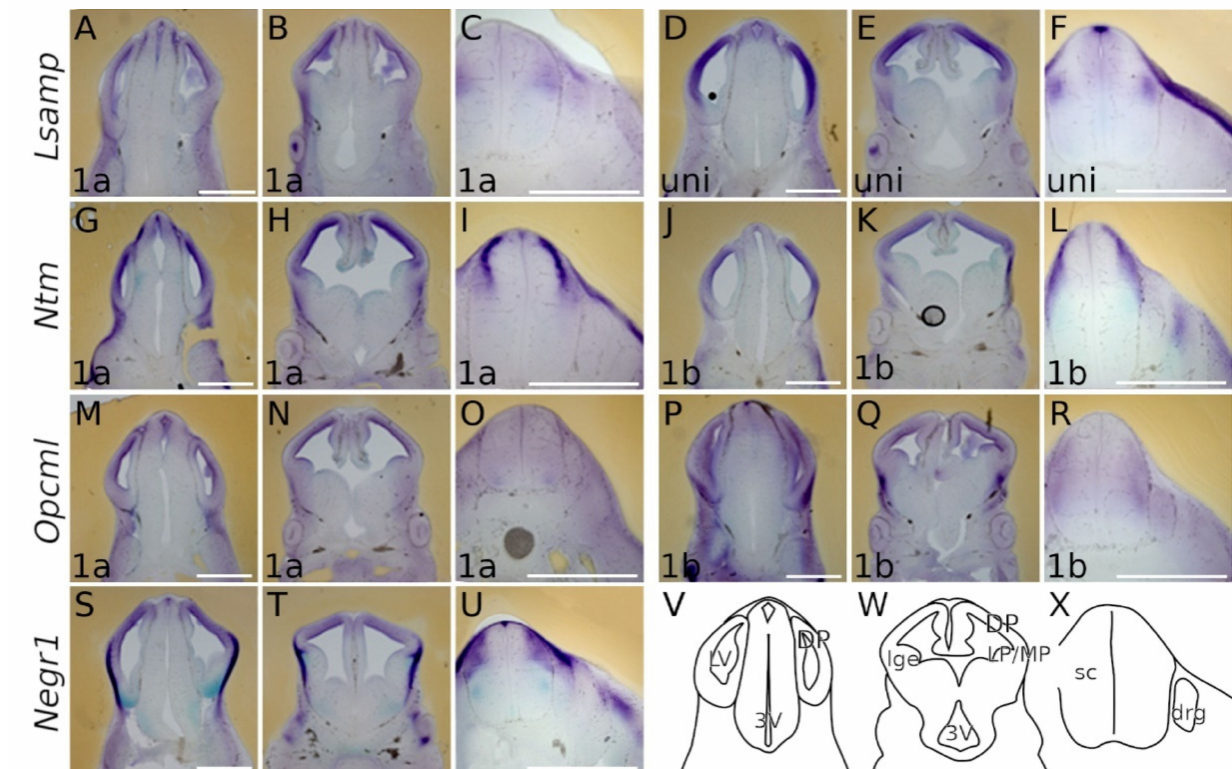
Figure 2. Expression from IgLON alternative promoters in E13.5 mouse CNS. Whole-mount in situ mRNA hybridization. ( A , D , G , J , M , P , S ) coronal sections through caudal telencephalon and ( B , E , H , K , N , Q , T ) telencephalon at intermediate level through interventricular foramen (laterally), showing preoptic area, hypothalamus and diencephalon (medial portions). All observed IgLON transcripts are present in DP from ventricular to pial surface along the rostral-caudal axis; Negr1 and Opcml 1b give strong signal also in LP. ( C , F ) Lsamp 1a/uni expression is seen dorso-laterally in developing sensory input area of sc while Lsampuni marks the roof plate. ( I , L ) Ntm 1a and 1b occupy the dorsal portion of the neural tube rather complementary: Ntm 1a is strongly expressed below the Ntm 1b domain. ( O ) weak uniform Opcml 1a signal is detectable through the developing sc, being somewhat stronger in the motor region ( R ) Opcml 1b occupies the lateral portion of sc. ( U ) Negr1 expression is complementary to ( C , F ) Lsamp 1a/uni with the exception seen at roof plate. ( V – X ) schemes of cutting planes. Abbreviations: sc, spinal cord; DP, dorsal pallium; LP, lateral pallium; VP, ventral pallium; lge, lateral ganglionic eminence; Lsampuni (Lsamp 1a + 1b) ; LV, lateral ventricle; 3V, third ventricle; drg, dorsal root ganglion. Scale bar: 1